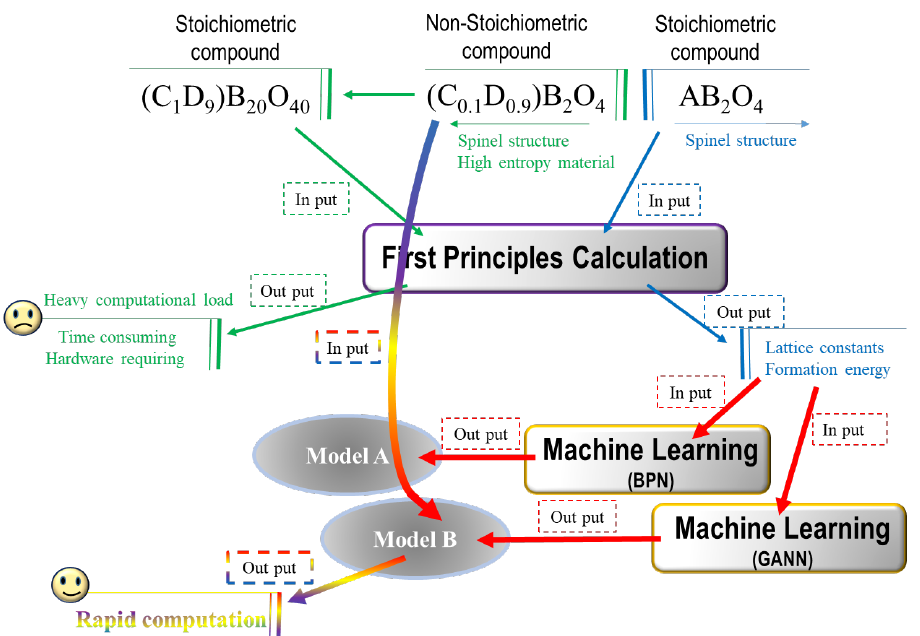
Figure 1. A schematic of the main concepts of the experiment. The blue region indicates that the physical properties of the binary and ternary spinel compounds are calculated by using the DFT calculations. The green area indicates that the non-stoichiometric compound to be calculated requires the creation of a stoichiometric compound first; thus, the computational load is heavy. The red region indicates that the calculated physical properties of binary and ternary spinel compounds are used as machine learning input files, and then the predicted physical properties of the non-stoichiometric compound are obtained by using machine learning.